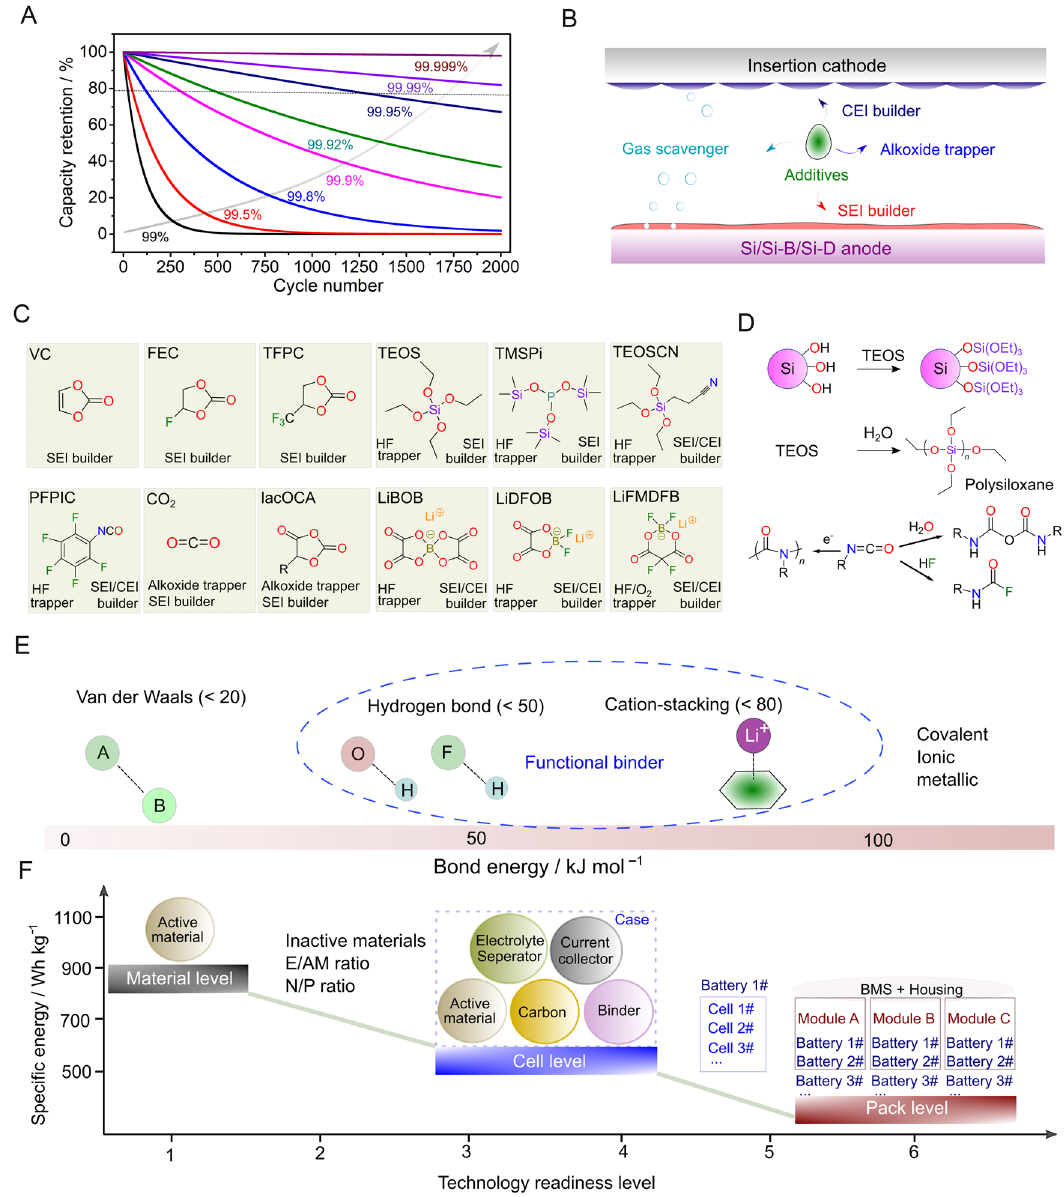
Fig. 6 Mitigating strategies for improving the performance of Si/Si-B/Si-D||IC cells. A In fl uence of CE on capacity retention in a hypothetical Si/Si-B/Si- D||IC full cell. B Role of an electrolyte additive in Si/Si-B/Si-D||IC cells. C Chemical structures and functions of popular electrolyte additives. D Chemistry of representative electrolyte additives. E Bond energies of various interactions existing in battery materials. F Evolution of speci fi c energy from the material to the cell and pack